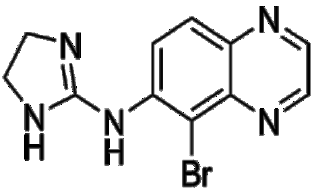
Figure 1. Chemical Structure of Brimonidine